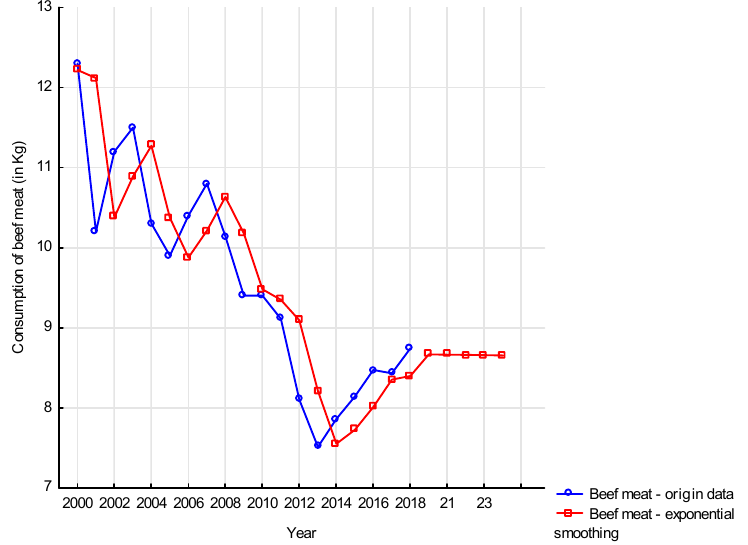
Figure 16. Prediction of beef consumption in the Czech Republic until 2024 [27].